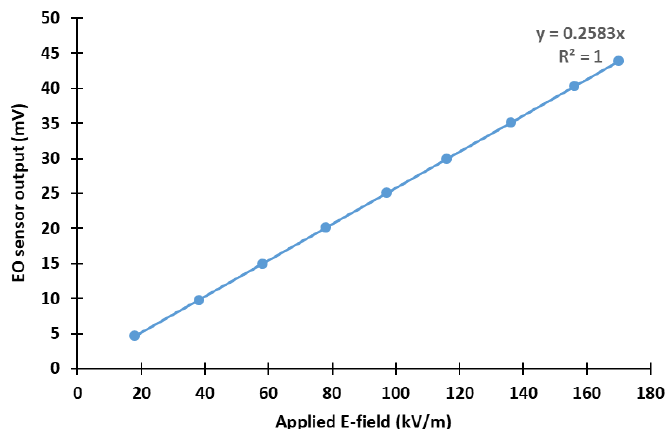
Figure 6. Results of the calibration of the EO E-field system obtained at 60 Hz using a two plane-to-plane circular electrode configuration.